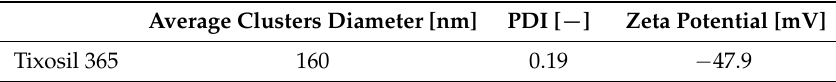
Table 1. Properties of the dispersion of SiO 2 NPs in